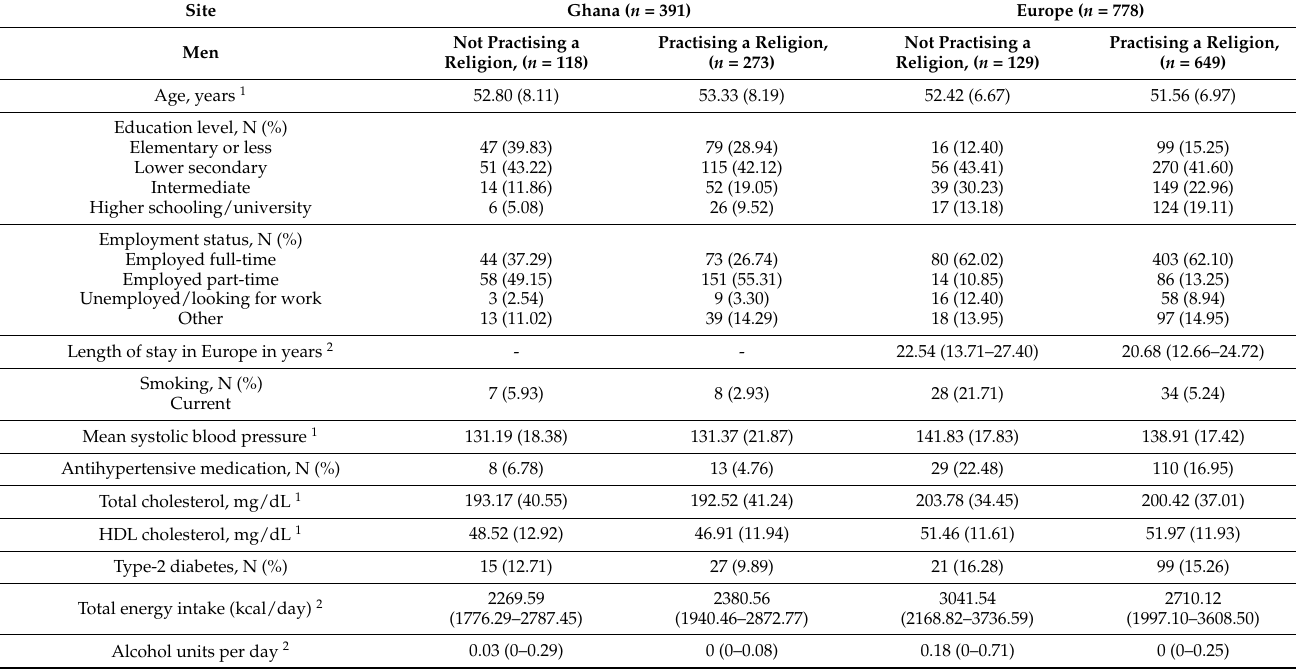
Table 1. General characteristics of the male Research on Obesity and Diabetes among African Migrants (RODAM) study